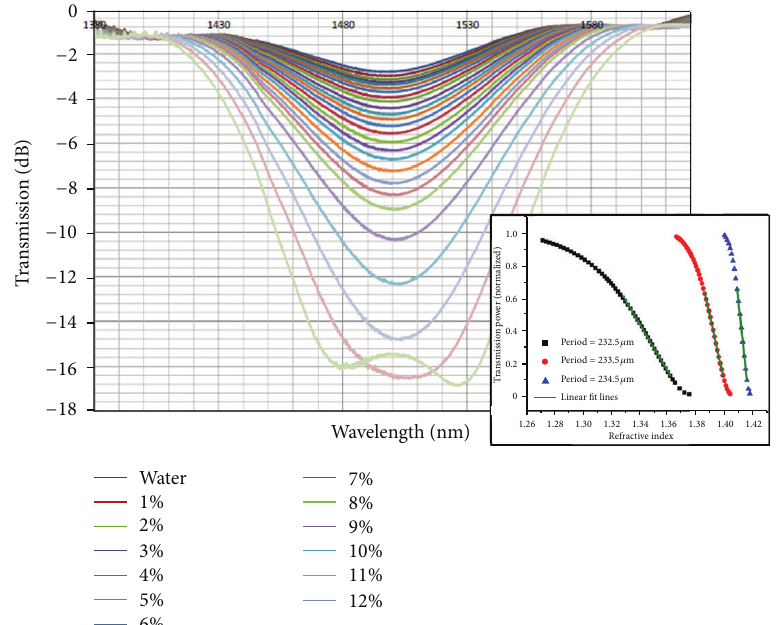
Figure 5: Change of the intensity of a particular mode as a function of the external refractive index. Inset: the choice of the period enables the tuning of the sensitivity for different refractive indices to be measured (taken from [33, 34]).